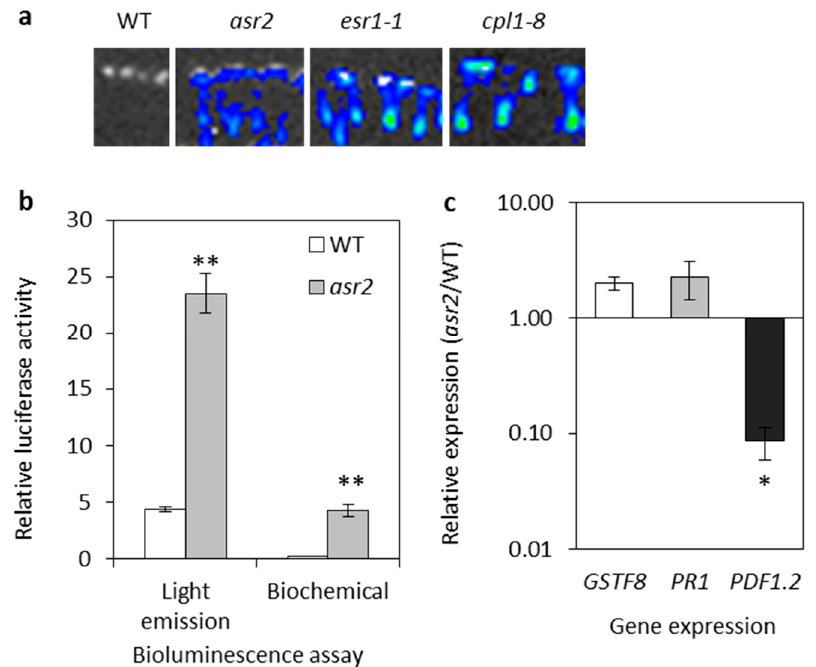
Figure 1. asr2 causes basal hyper-expression of GSTF8::LUC and altered defence marker gene expression. ( a ) Comparison of basal GSTF8:LUC expression in four-day-old wild-type (WT), asr2 , esr1-1, and cpl1-8 ( esr3-2 ) seedlings. ( b ) Quantification of bioluminescence via in vivo light emission (relative light units/seedling; values are averages ± SE ( n = 30) from four-day-old seedlings) and in vitro biochemical assays (units/20sec/mg protein; values are averages ± SE ( n = 30) from nine-day-old seedlings). ( c ) GSTF8 , PR1, and PDF1.2 expression in seven-day-old seedlings (values are averages ± SE of two biological replicates consisting of pools of 20 seedlings). Gene expression levels are expressed logarithmically relative to the normalised expression levels in WT plants. For normalisation, the internal control EF-1 gene was used. Asterisks indicate values that are significantly different (** p < 0.01, * p < 0.05 Student’s t -test) from WT.